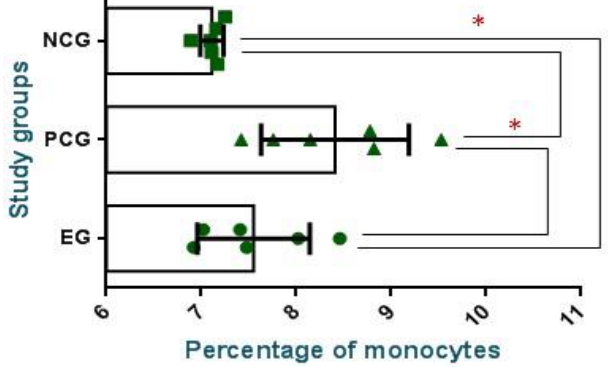
Figure 7. Total results of monocytes among the experim- ental groups and the time points. (*) referred to significant differences between groups as